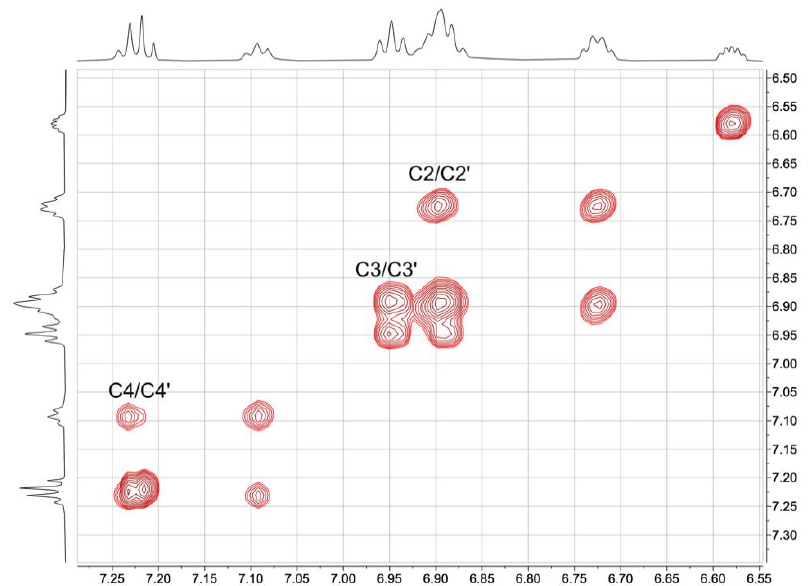
Figure 6. EXSY peaks in the NOESY spectrum (500 MHz, C 2 D 2 Cl 4 , 328 K) of [Cu(xantphos)(biq)][PF 6 ] between resonances for pairs of phenyl protons.